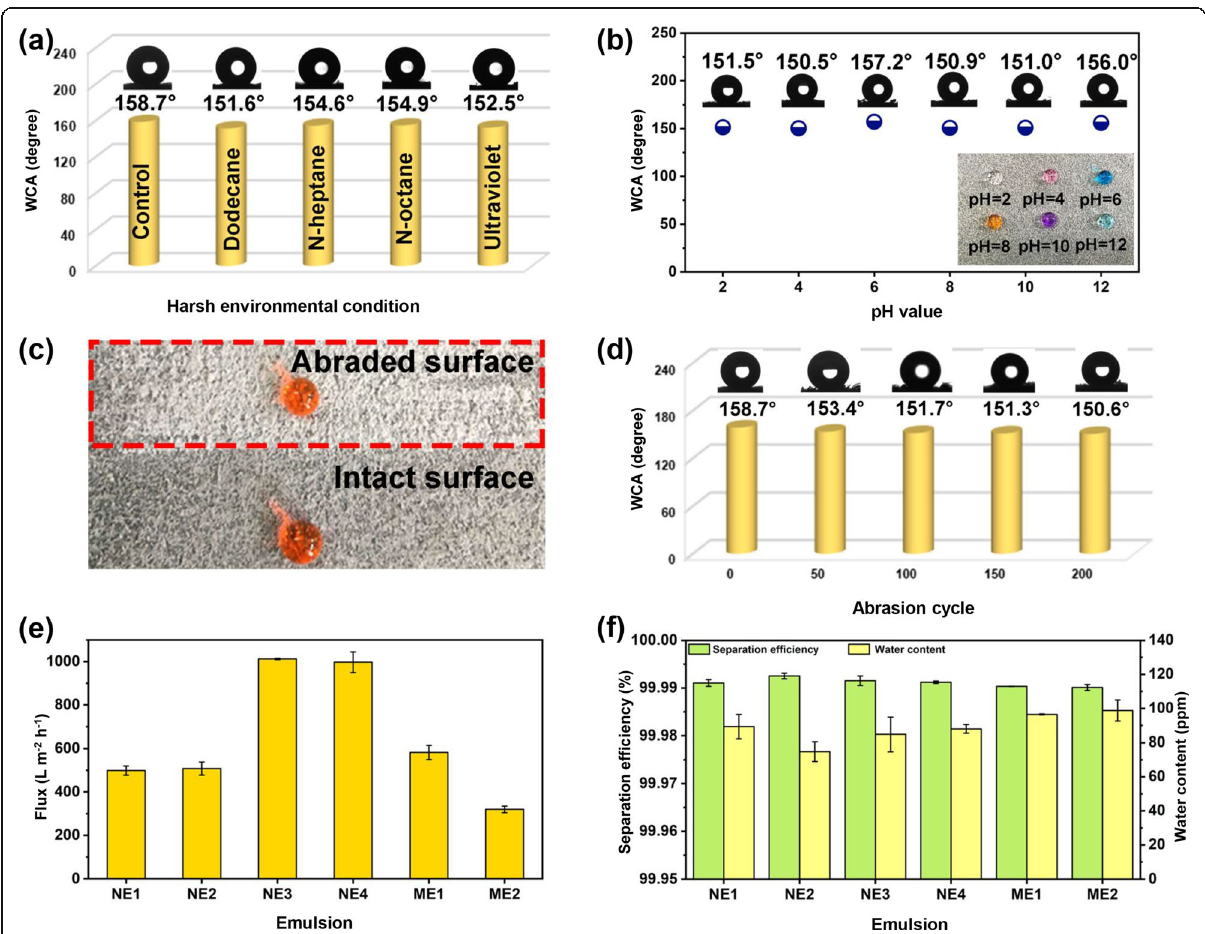
Fig. 4 The WCAs of the CFM/UiO-66(12)/PDMS membrane before and after exposed to different harsh environments for 24 h ( a ), the WCAs of the CFM/UiO-66(12)/PDMS membrane immersed in aqueous solutions at varied pH (2 – 12) for 24 h ( b ) (inset in b shows the digital photographs of 30 µL of water droplets at pH2 – 12 on the surface of the CFM/UiO-66(12)/PDMS membrane), digital photographs of water droplets (30 µL) on the surface of the CFM/UiO-66(12)/PDMS membrane abraded with sandpaper for 200 cycles ( c ), the WCAs of the CFM/UiO-66(12)/PDMS membrane abraded with sandpaper for different cycles ( d ), separation fluxes of the double-layer CFM/UiO-66(12)/PDMS membranes assembled by two membranes that were treated by abrasion with sandpaper for 200 cycles to NE1, NE2, NE3, NE4, ME1 and ME2 ( e ), the corresponding water contents in the filtrates and the corresponding separation efficiencies( f